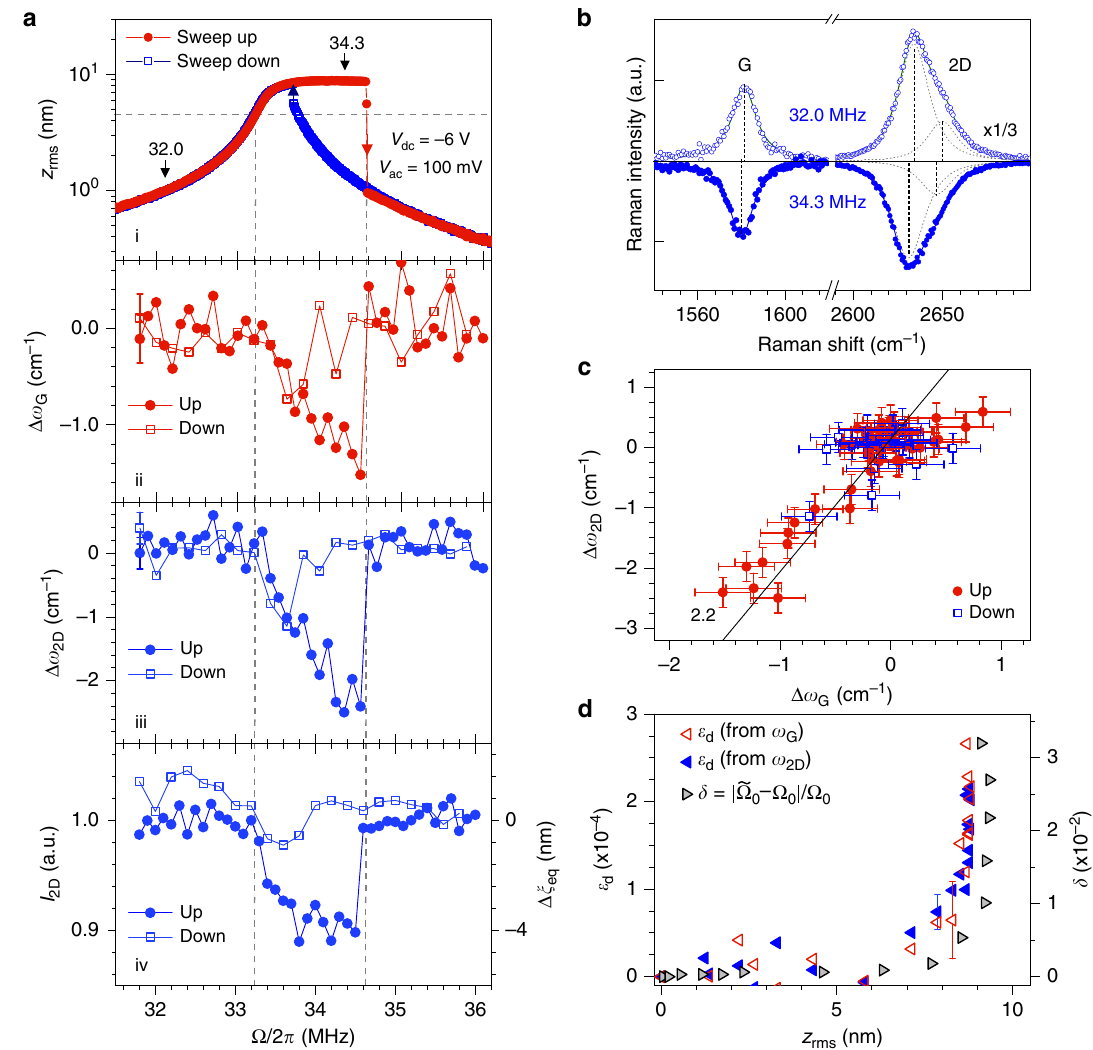
Fig. 3 Frequency-dependent dynamically-induced strain. All measurements are performed on device 1 under V dc = − 6V a Panel i: RMS mechanical amplitude z rms as a function of the drive frequency Ω /2 π under V ac = 100 mV. Red fi lled circles and blue open squares indicate upward and downward frequency sweeps. The blue and red arrows denote the jump-down and jump-up frequencies in the non-linear hardening region, respectively. The dashed lines are guides to the eye. Panels ii and iii: Raman frequency shifts Δ ω G and Δ ω 2D as a function of Ω /2 π . Panel iv: integrated intensity of the 2D-mode feature as a function of Ω /2 π . Filled and open symbols in panels 2-4 correspond to upward and downward frequency sweeps, respectively. b Raman spectra recorded at Ω /2 π = 32 MHz (open symbols and fi t) and 34.3 MHz ( fi lled symbols and fi t, vertically fl ipped for clarity), see arrows in a . c Correlation between the frequency shifts Δ ω G and Δ ω 2D , relative to the values recorded away from the mechanical resonance. The straight black line with a slope of 2.2 is a guide to the eye for the strain-induced phonon softening. d Time-averaged dynamical strain ε d extracted from the softening of G-mode and 2D-mode features in a -ii and a -iii (open red and fi lled blue triangles, respectively) as a function of the RMS amplitude z rms . The right axis (grey (cid:2) (cid:2) (cid:2) (cid:2) = Ω e Ω triangles) shows the relative non-linear mechanical resonance frequency shift δ ¼ e Ω 0 (cid:2) Ω 0 0 , where 0 is the jump-down frequency (see a and Supplementary Note 6). Error bars in a , c , d are extracted from the fi ts of Raman spectra. Only one error bar is included in a and d for